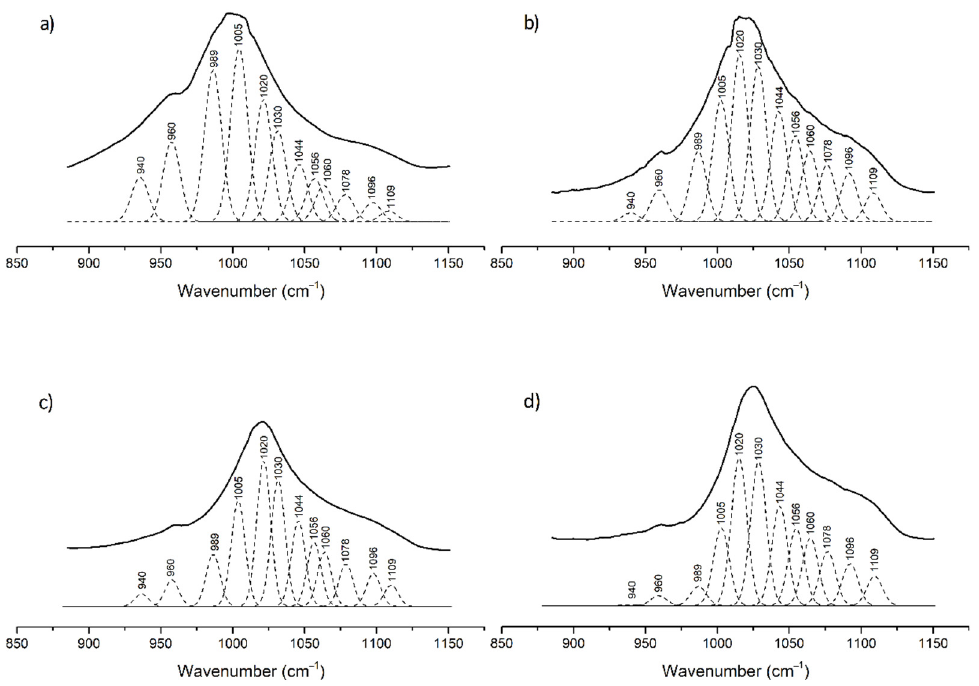
Figure 2. ATR-FTIR peaks profile in the phosphate absorption band ( v 1 , v 3 PO 43 − ): ( a ) sound dentine, ( b ) carious dentine, ( c ) pHc for 14 days, and ( d ) pHc for 28 days. Peaks assignment: ∼ 940 cm − 1 ( v 1 P-O symmetry stretching mode), ∼ 960 cm − 1 ( v 1 PO 43 − ), ∼ 996 cm − 1 (PO 43 − in apatite environment), ∼ 1005 cm − 1 ( v 3 PO 43 − ), ∼ 1020 cm − 1 ( v 3 PO 43 − in poorly crystalline apatites), ∼ 1030 cm − 1 ( v 3 PO 43 − in stoi- chiometric apatites), ∼ 1044 cm − 1 (HPO 42 − containing apatites and type B carbonated substitution), ∼ 1056 cm − 1 (T 2 vibrational modes of apatites), ∼ 1060 cm − 1 ( v 3 PO 43 − in poorly crystalline apatites),